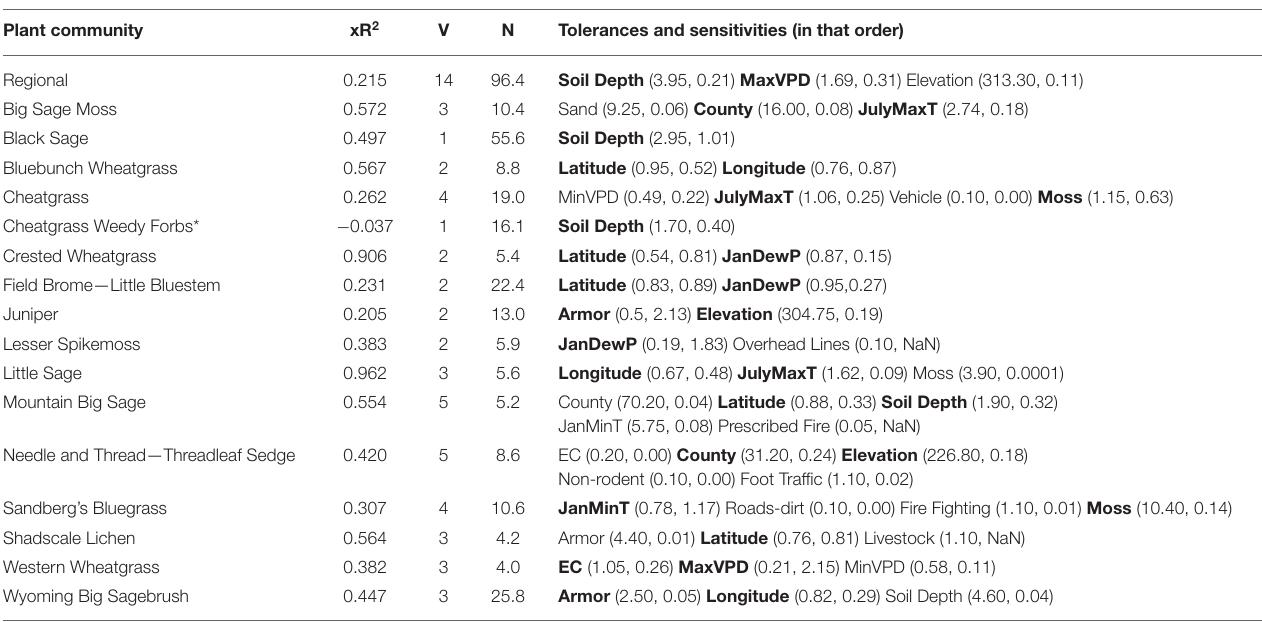
TABLE 1 | Best NPMR models for lichen cover by plant